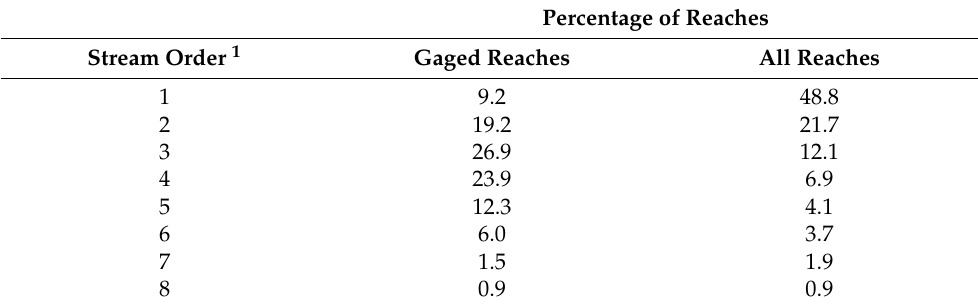
Table 1. Size distribution for stream reaches in the Upper Colorado River